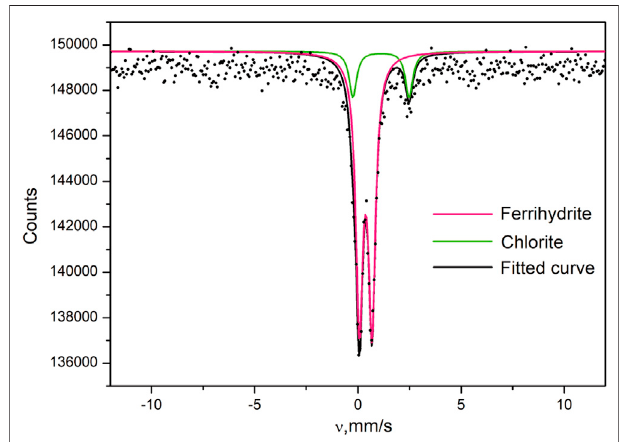
FIGURE 7 | 57 Fe Mössbauer spectrum of the rusty parts from 0719 recorded at room temperature.